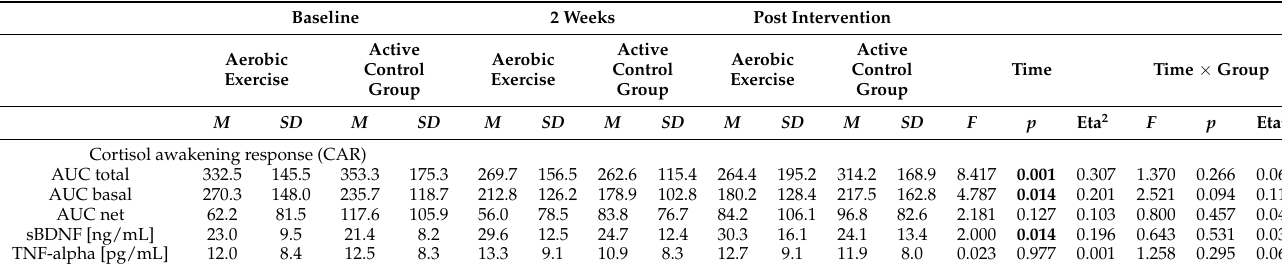
Figure 1. Cortisol awakening response for each timepoint by group. At each timepoint there was a significant increase of salivary cortisol ( p < 0.001). Error bars represent standard error (SE). Table 2. Neurobiological